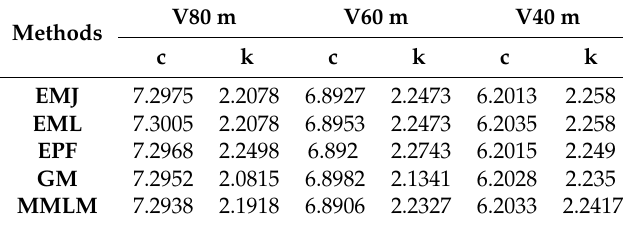
Table 6. Values of shape (k) and scale (c) Weibull parameters using five different methods.